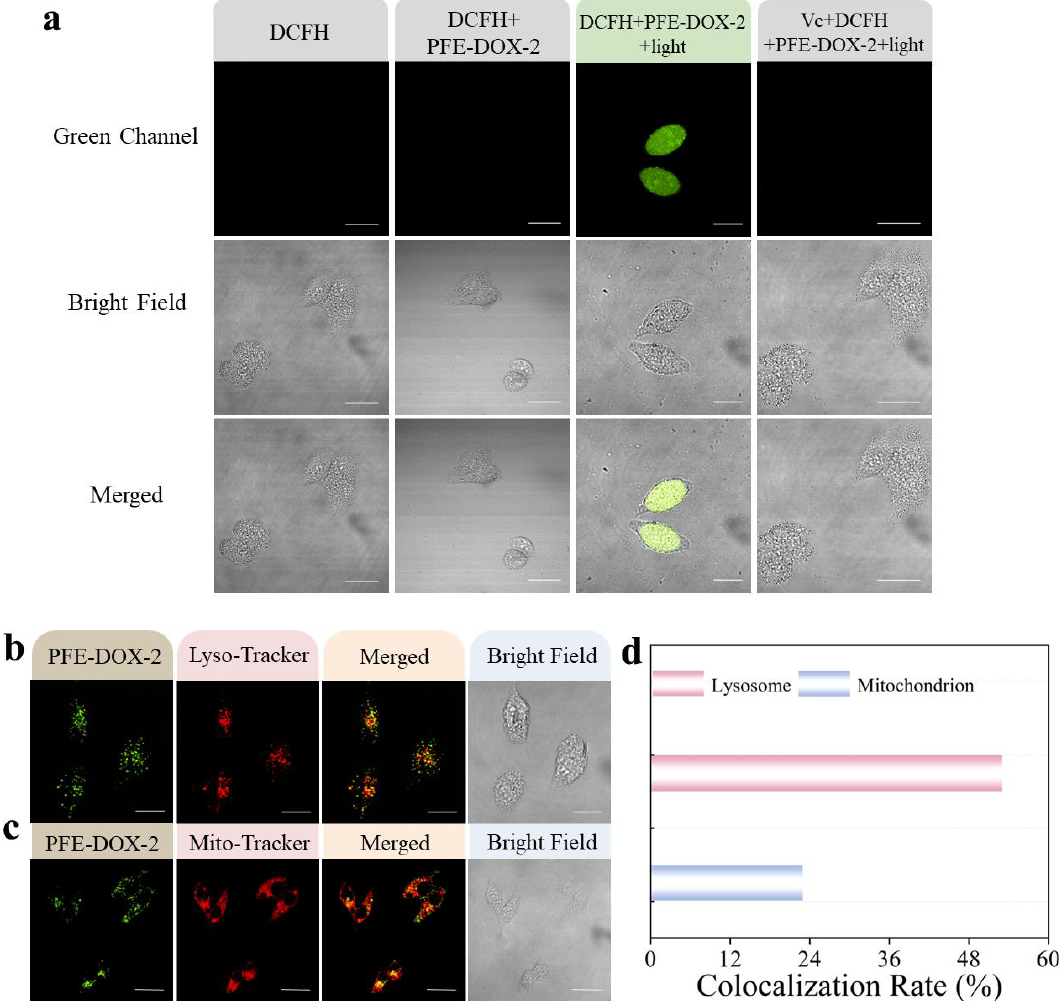
Figure 5 . ( a ) Detection of ROS generation ability of PFE-DOX-2 in MCF-7 cells with or without light irradiation (90 mW cm −2 ) for 15 min. The fluorescence signal was collected in the range of 500 – 600 nm ( λ ex : 488 nm) for DCFH. [PFE-DOX- 2] = 1 μM, [DCFH] = 20 μM, [Vc] = 100 μM. CLSM images of MCF-7 cells treated with PFE-DOX-2 ( 1 μM ) and stained with ( b ) Lyso-Tracker red DND 99 and ( c ) Mito-Tracker Deep Red FM. The fluorescence signal was collected in the range of 410 – 460 nm ( λ ex : 405 nm) for PFE-DOX-2, 575 – 620 nm ( λ ex : 559 nm) for Lyso-Tracker red DND 99, and 650 – 700 nm ( λ ex : 635 nm) for Mito- Tracker Deep Red FM, respectively. Scale bar is 40 μm. ( d ) Pearson’s coeffi- cient of PFE-DOX-2 and Lyso-Tracker red DND 99 or Mito-Tracker Deep Red FM in MCF-7 cells.